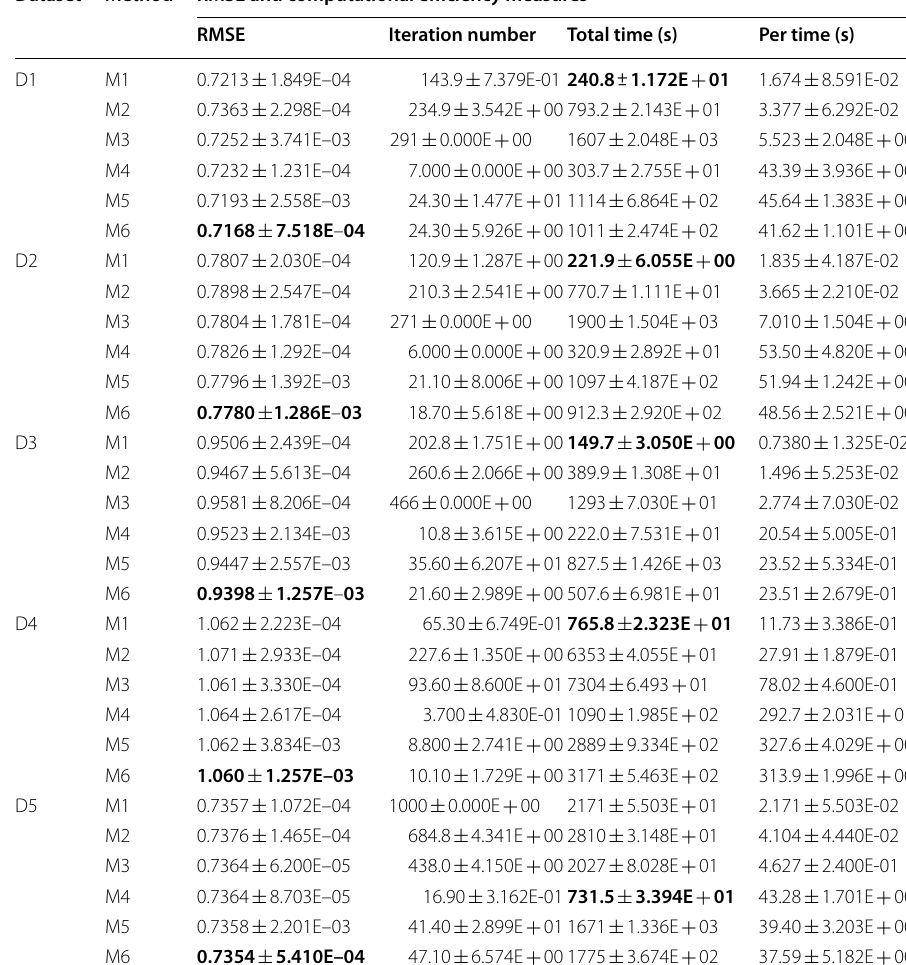
Table 4 Mean RMSE results Dataset Method RMSE and computational efficiency